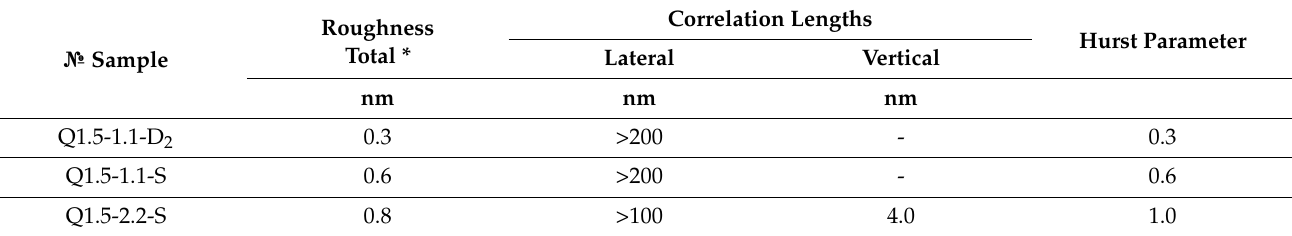
Table 3. Roughness and lateral and vertical correlation lengths; Hurst parameters of MQW structures from the simulation of transverse XRR scans of the first Bragg reflection in Figure